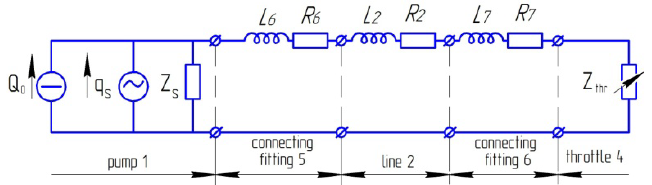
Figure 14. Calculated hydrodynamic model of the bench system implementing an inertial load. R 2 , L 2 —active resistance and “inertia” of the connecting line, respectively; R 6 , L 6 —active resistance and “inertia” of the connecting fittings and the inner pump channel, respectively; R 7 , L 7 —active resistance and “inertia” of the connecting fittings and the inner cavity channel, respectively.